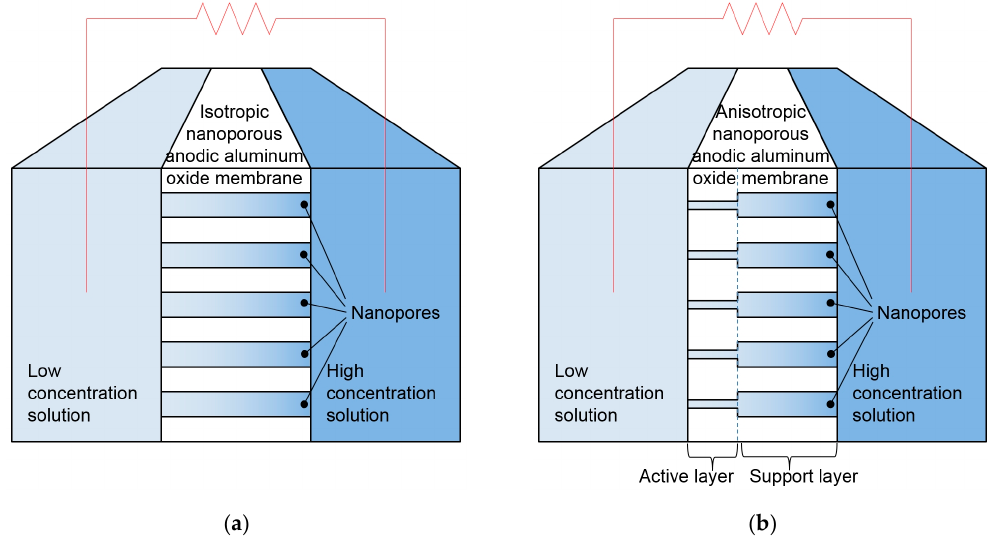
Figure 2. Schematic diagrams of nanoporous anodic aluminum oxide membranes for reverse electrodialysis: ( a ) isotropic membrane; ( b ) anisotropic membrane.